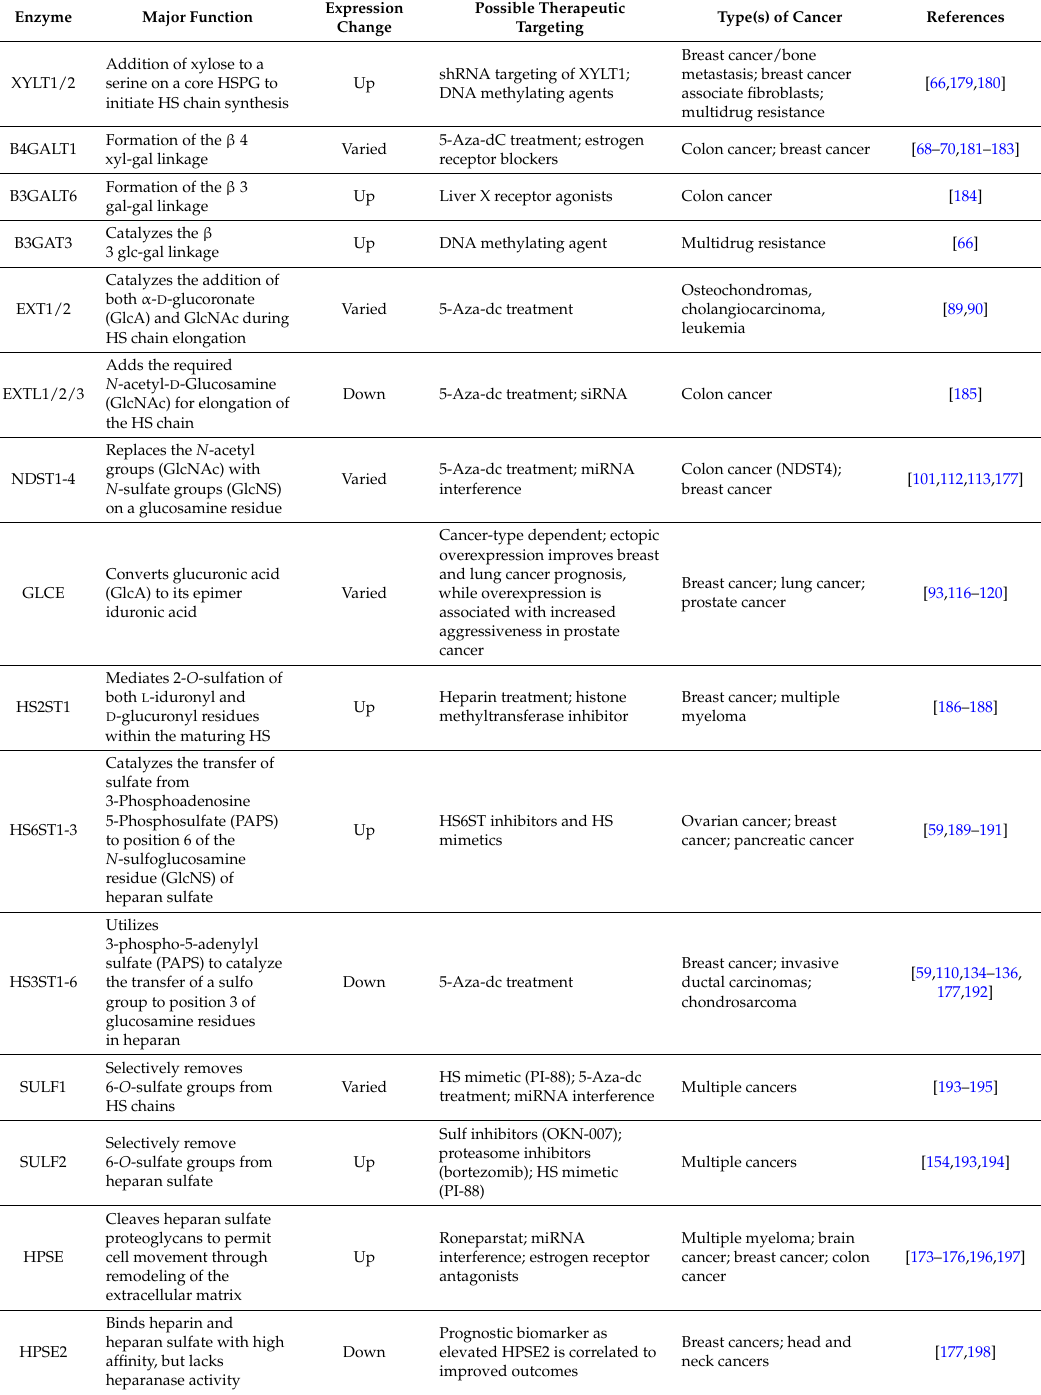
Table 1. Heparan sulfate proteoglycan (HSPG) enzymes involved in tumor progression.